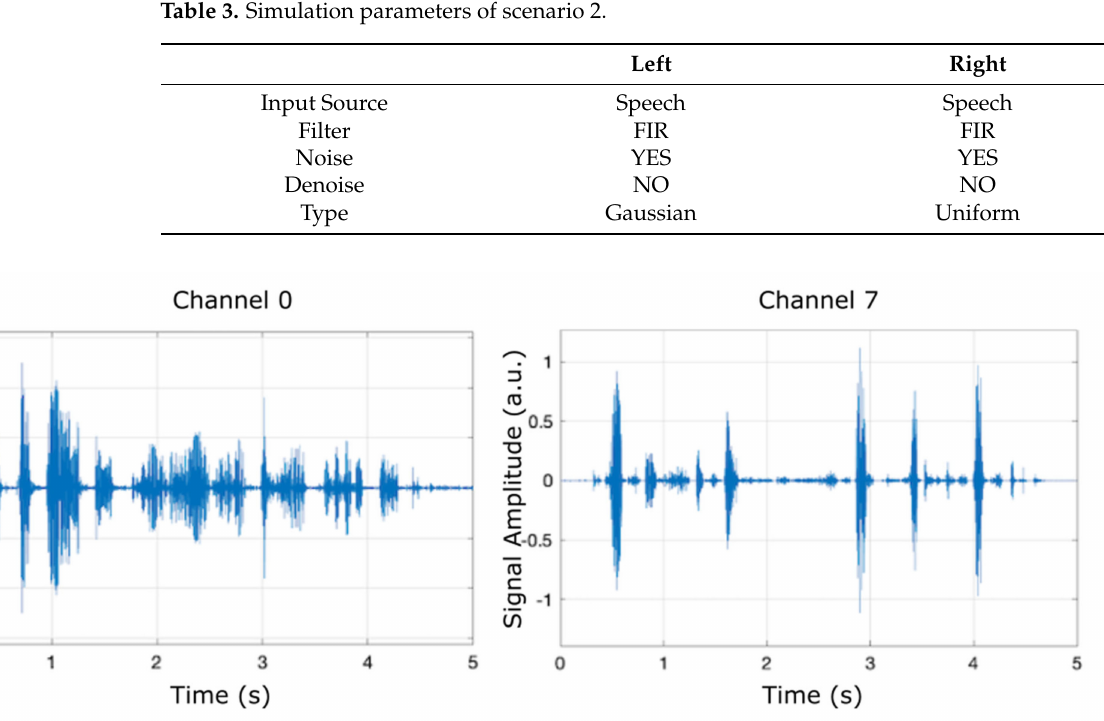
Figure 5. Results of electrical pulse generator for two channels (channel 0 and channel 7) under the FIR filter, without noise, and without denoise blocks (scenario as in Table